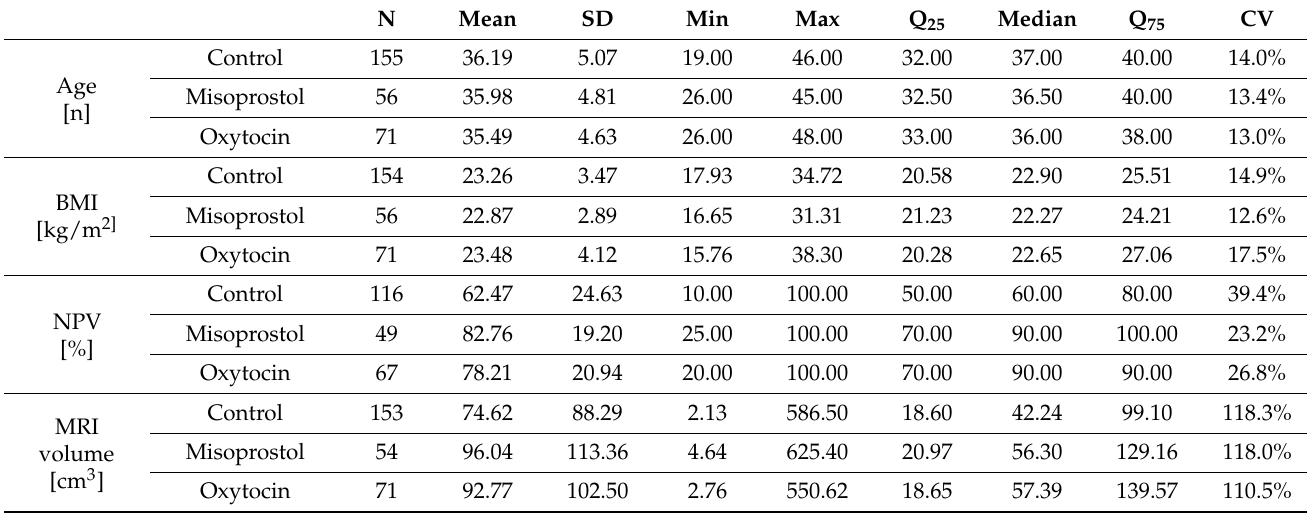
Table 3. Characteristics of selected parameters of the studied women and MR-HIFU results (single parameters are missed).